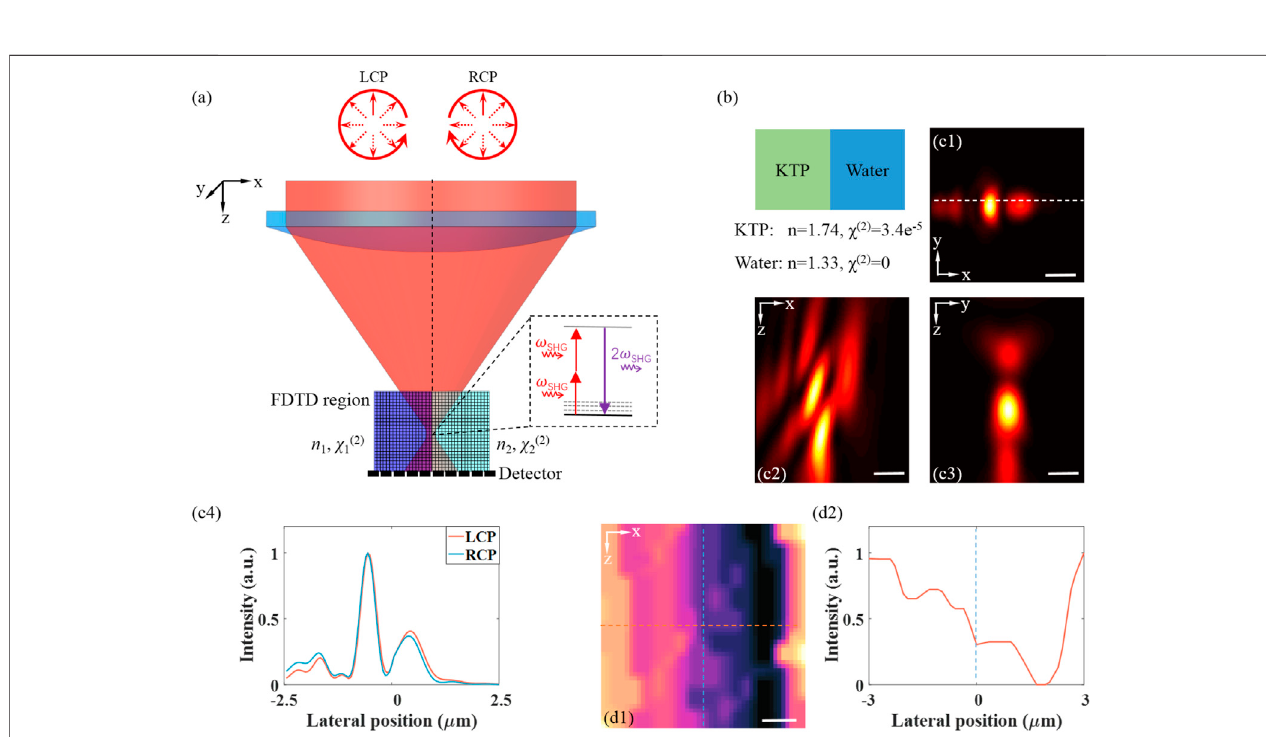
Frontiers in Chemistry |